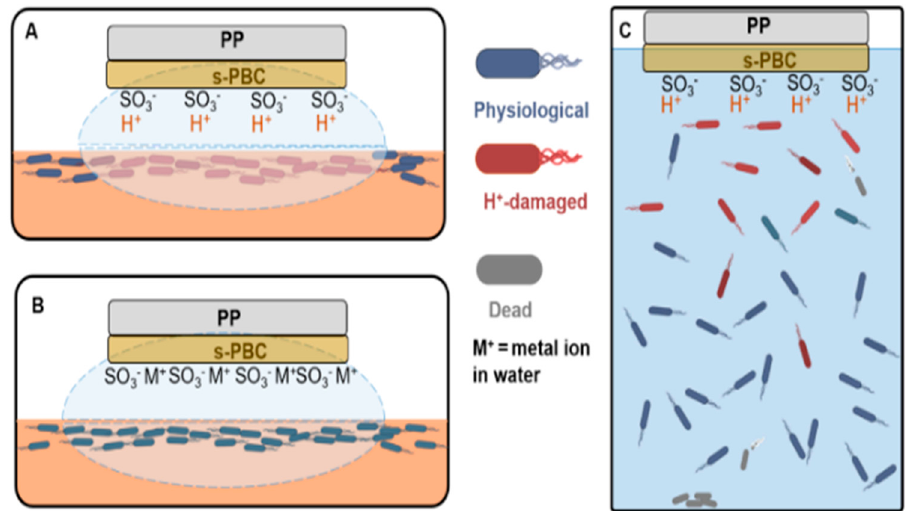
Figure 9. Schematic representation of P. aeruginosa death induced by s-PBC@PP and water: ( A ) acid s-PBC@PP in small volume system; ( B ) neutralized s-PBC@PP in small volume system; ( C ) acid s-PBC@PP in large volume system. Physiological (blue), damaged (red), and dead (gray) bacteria are indicated with different colors.